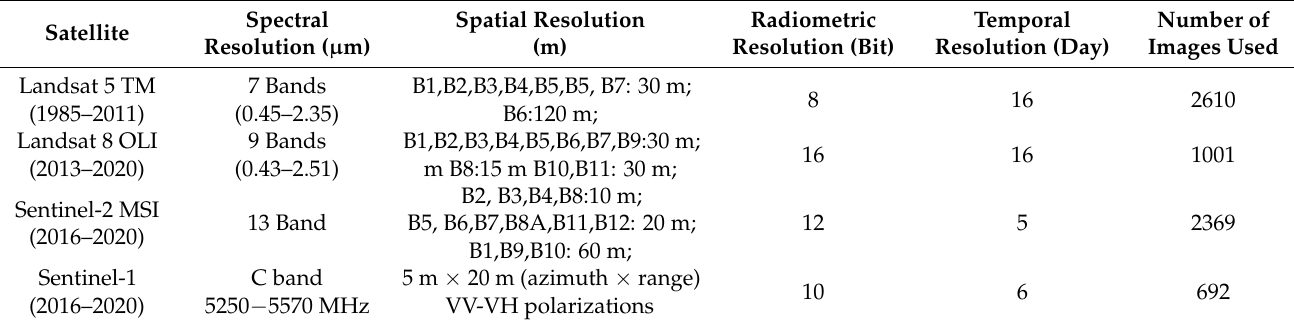
Table 2. Detailed information of optic and SAR satellite images used.